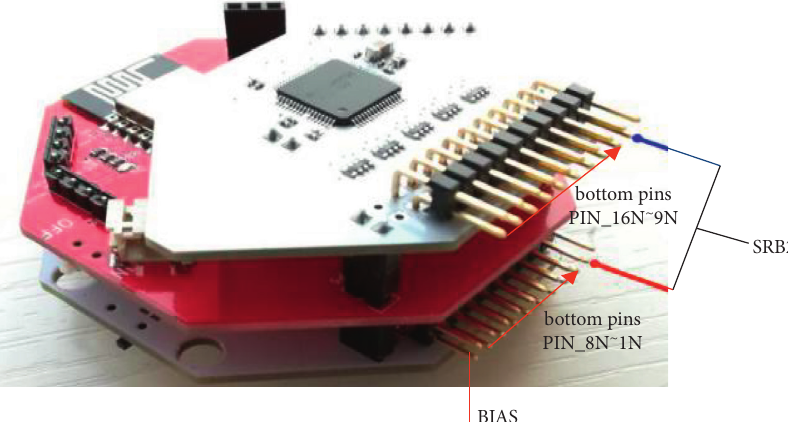
Figure 5: Connection of Wi-Fi shield, OpenBCI motherboard, and OpenBCI expansion board.